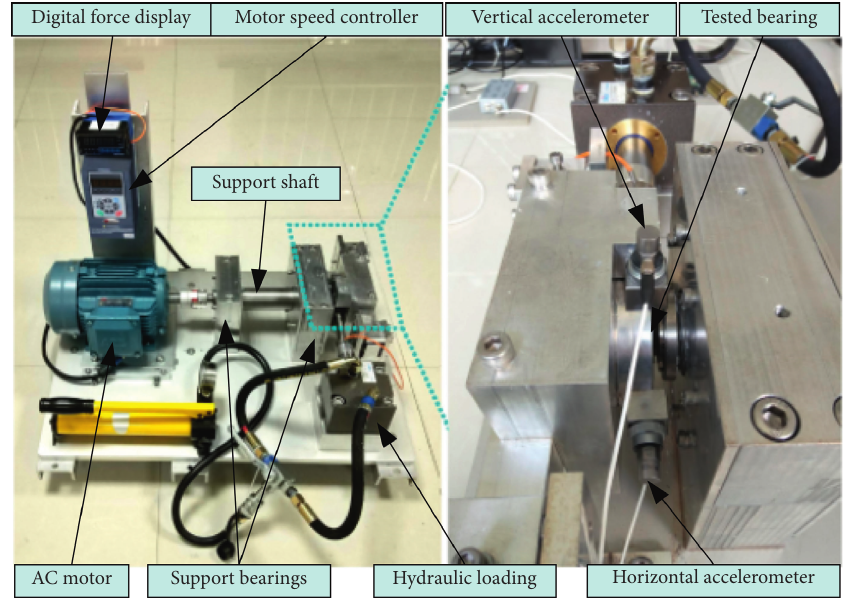
Figure 5: Rolling bearing test